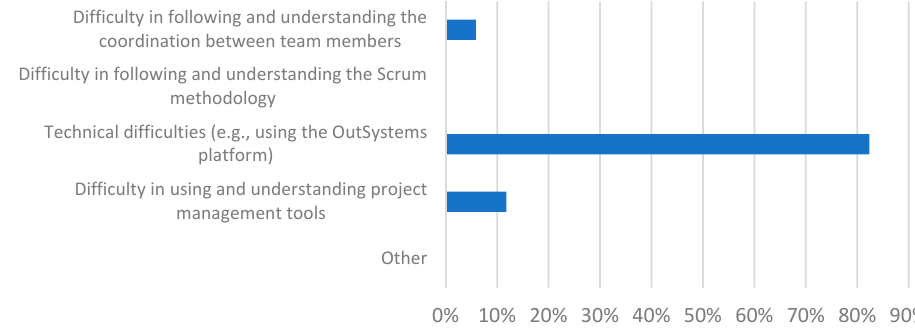
Figure 8. Most important challenges students had to face.